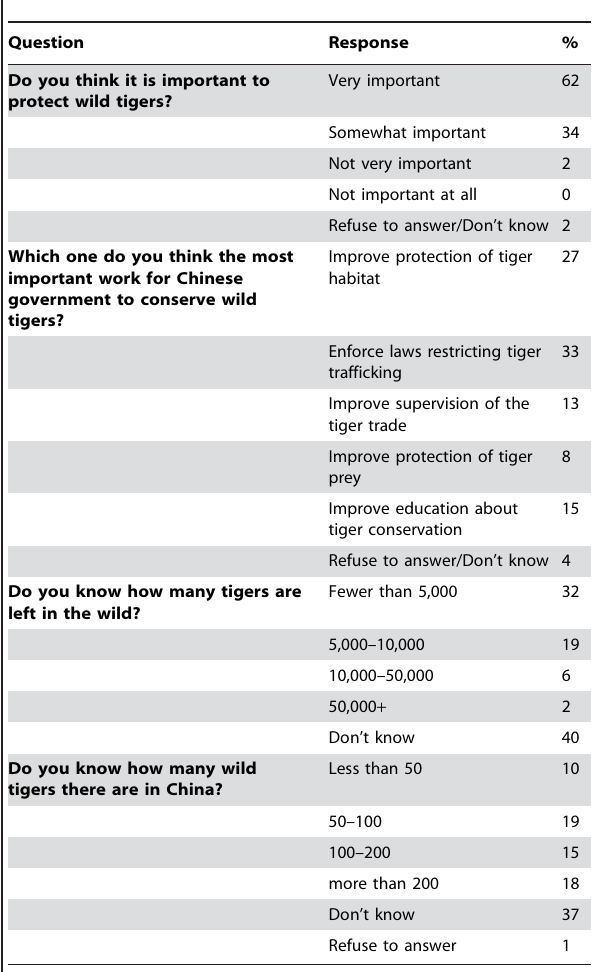
Chinese cities (N =1880, % rounded to nearest whole